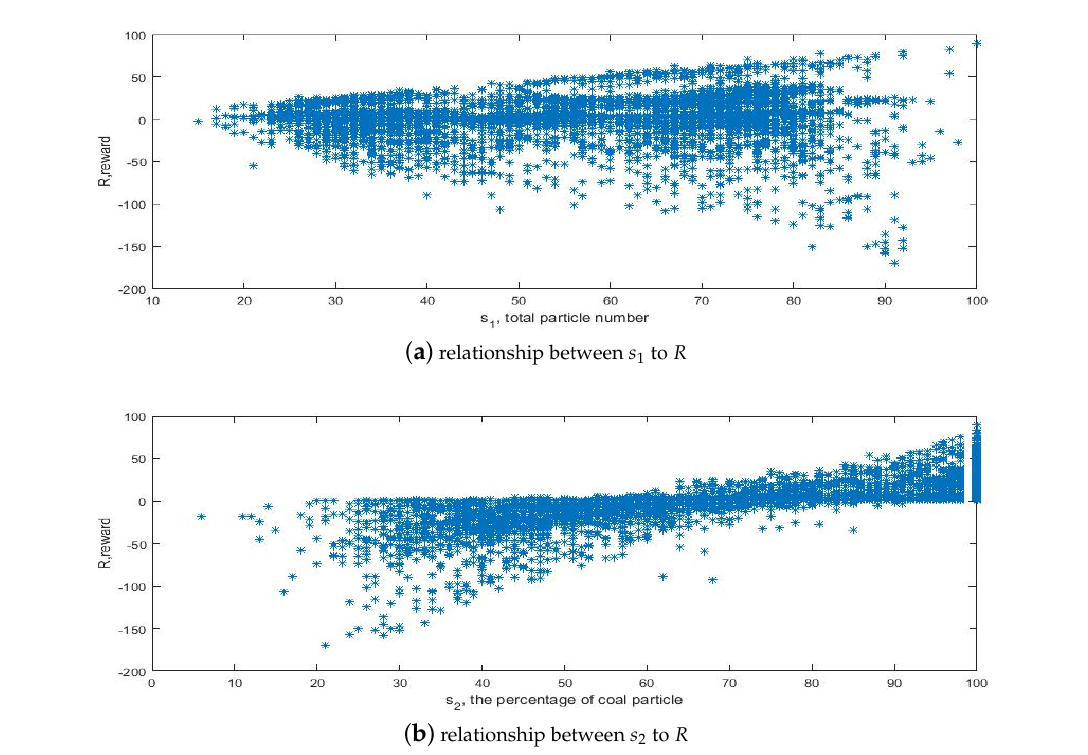
Figure 4. Experience distribution: ( a ) it is easy to find that the absolute value of R grows as s 1 increases; ( b ) the outline of R is proportional to s 1 . They indicate that a network could be found to approximate the relationship between particles number, coal rate, and reward.